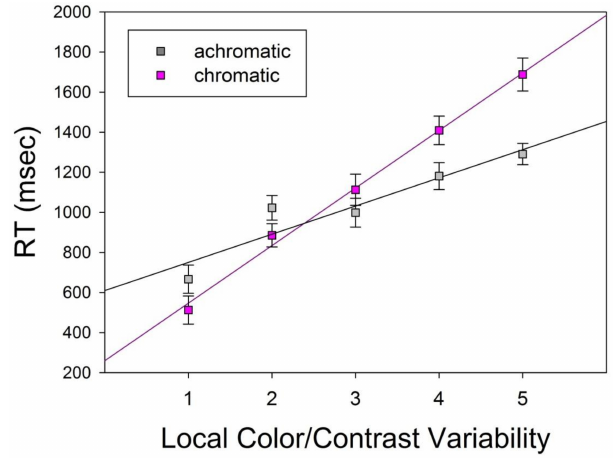
Figure 5. Average Response Time (RT) in milliseconds as a function of the two levels of the hue factor and the five levels of the variability factor reflecting increasing local color/contrast variations (complexity) across the axis of symmetry in the shape pairs. The error bars here indicate the standard deviations from the means. A linear model provides a good fit to the data for color (red regression line) and for achromatic (black regression line) data, with a moderately better fit in the case of color (R 2 = 0.99) by comparison with achromatic (R 2 =